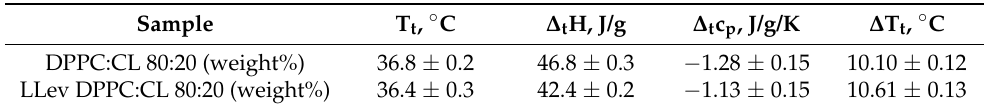
Table 4. Thermochemical characteristics of the phase transition of DPPC:CL liposomes and loaded with levofloxacin; 0.02 M Na phosphate buffer solution, pH